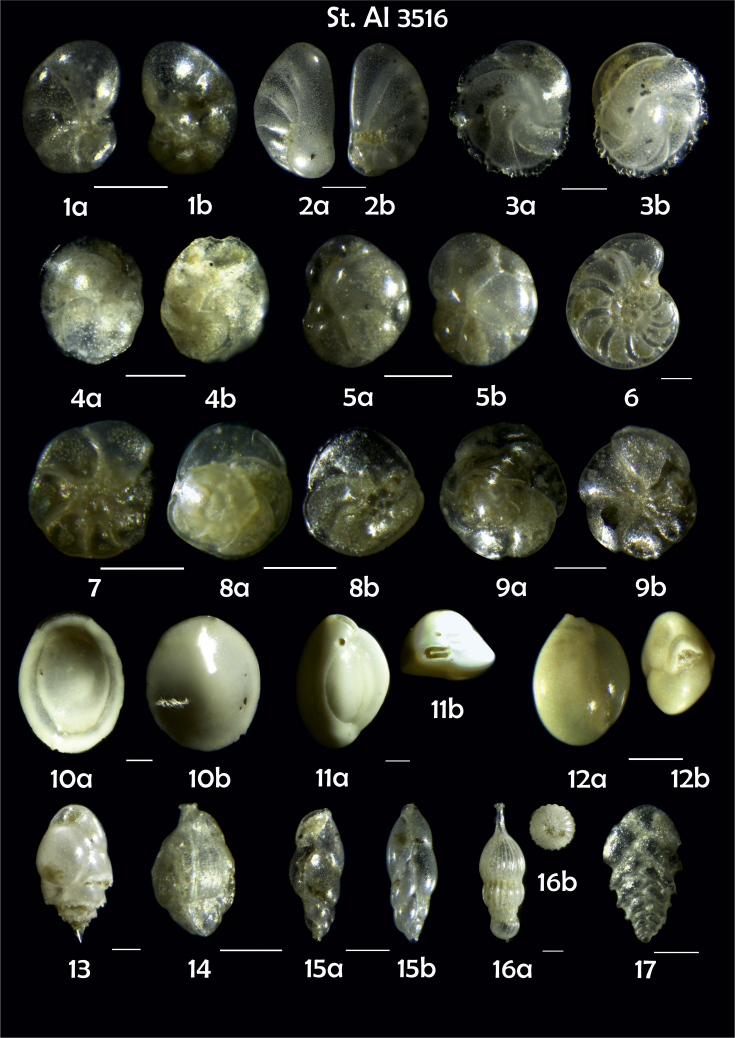
Station 35161Nonionella auricula,a umbilical view, b spiral view. 2N. turgida, a lateral view, b umbilical view. 3Cassidulina carinata, a latereal view, b apertural view. 4C. laevigata,a lateral view, b apertural view. 5C. reniforme, a apertural view, b lateral view. 6Hyalinea balthica. 7 ?. 8, 9Rosalina vilardeboana, a spiral view, b umbilical view. 10Pyrgo sp. 11Quinqueloculina seminula, a lataral view, b apertural view. 12Miliolinella subrotunda, a lataral view, b apertural view. 13Bulimina marginata. 14Trifarina angulosa. 15Fursenkoina fusiformis. 16Amphicoryna scalaris, a lataral view, b apertural view. 17Bolivina sp. Scale 100 μm.